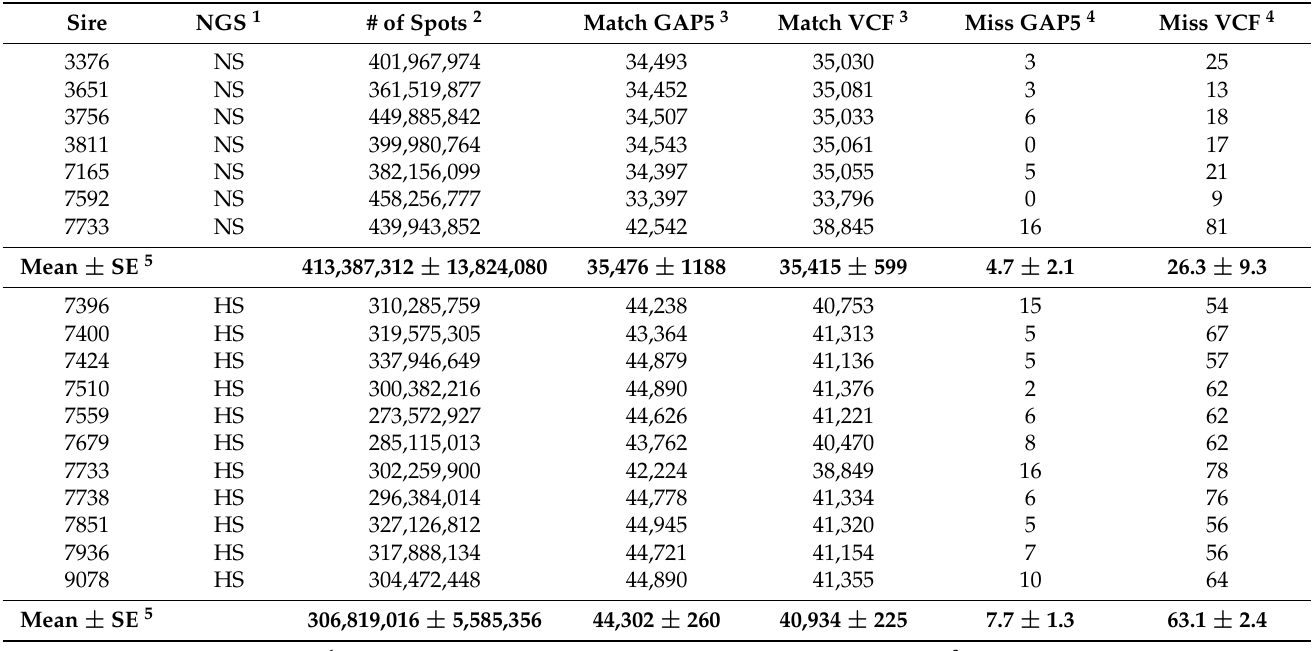
Table 1. Comparison between BeadChip and WGS